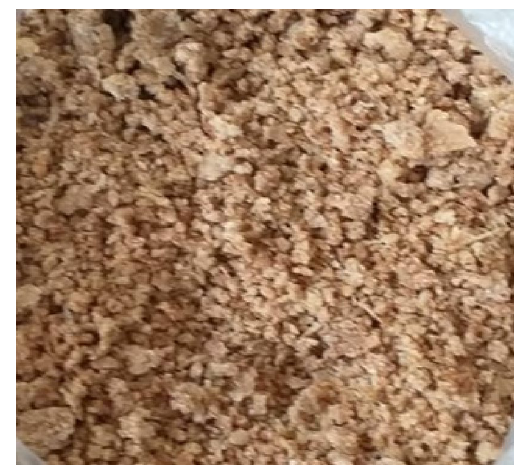
Fig. 1 Sample of Abelmoschus esculentus